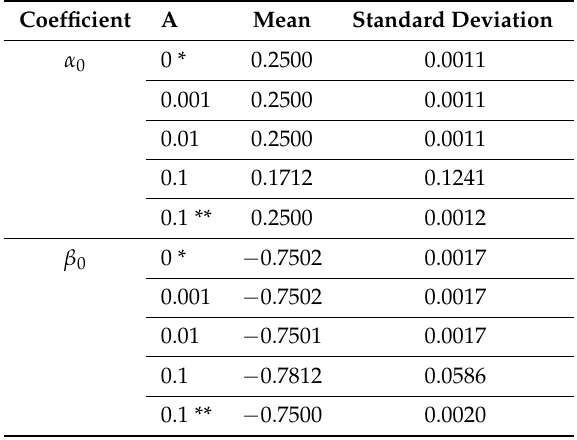
Figure 15. Estimations of α 0 and β 0 using the NII technique, with and without variations in the reference signal r ( k ) . Table 2. Statistics of the attack identification process using the NII technique, with and without variations in the reference signal r ( k )